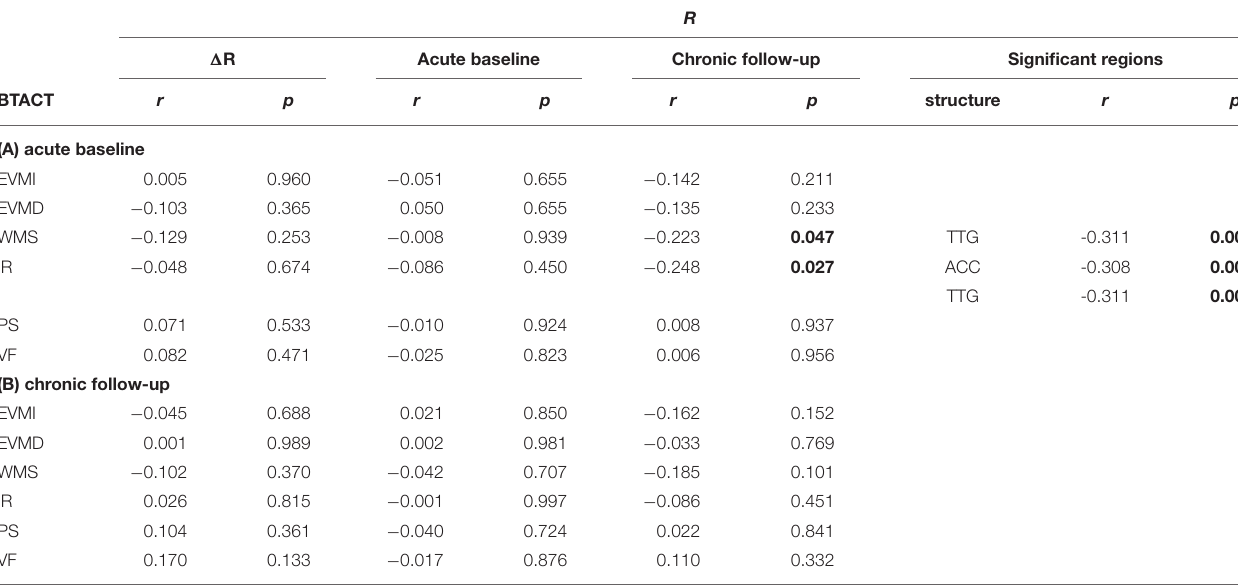
TABLE 3 | Spearman coefficients r and p -values for the correlation of relative myelin content R and cognitive scores for traumatic brain injury subjects, at 2 weeks and 6 months post injury. R 1 R Acute baseline Chronic follow-up Significant regions structure r